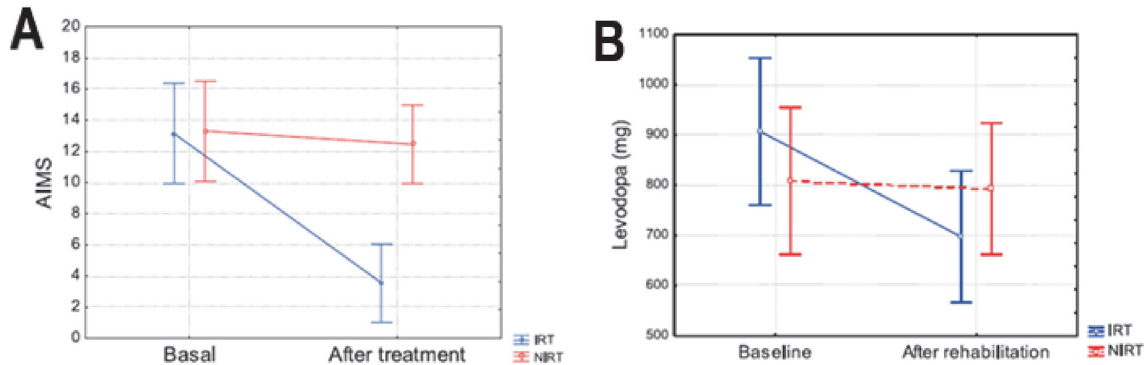
Figure 2 - Graphical representation of time-treatment interaction for the variable AIMS. Differences in the rehabilitation treatment (intensive and non- intensive) effect are reflected by those in the line's slope joining the mean value AIMS at baseline and after rehabilitation in the two groups (A). Patients undergoing the IRT protocol may decrease the levodopa dose after the rehabilitation protocol (B). AIMS, abnormal involuntary movement scale; IRT, intensive rehabilitation treatment; NIRT, nonintensive rehabilitation